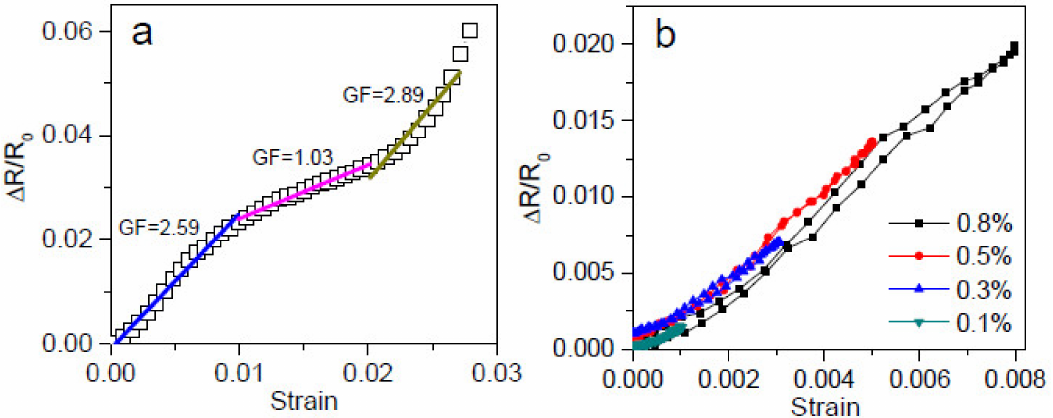
Figure 9. Relative change in resistance ( ∆ R / R 0 ) with applied monotonic tension loading for the CP_0.38GO. ( a ) Up to failure; ( b ) under progressively increasing strain from 0.1%, 0.3%, 0.5% to 0.8%. The gauge factor was 2.59 under 1% strain, 1.03 between 1% and 2%, and 2.89 between 2% and 3%, obtained by linear fitting of the ( ∆ R / R 0 ) vs. ε curve. Similar to Wang et